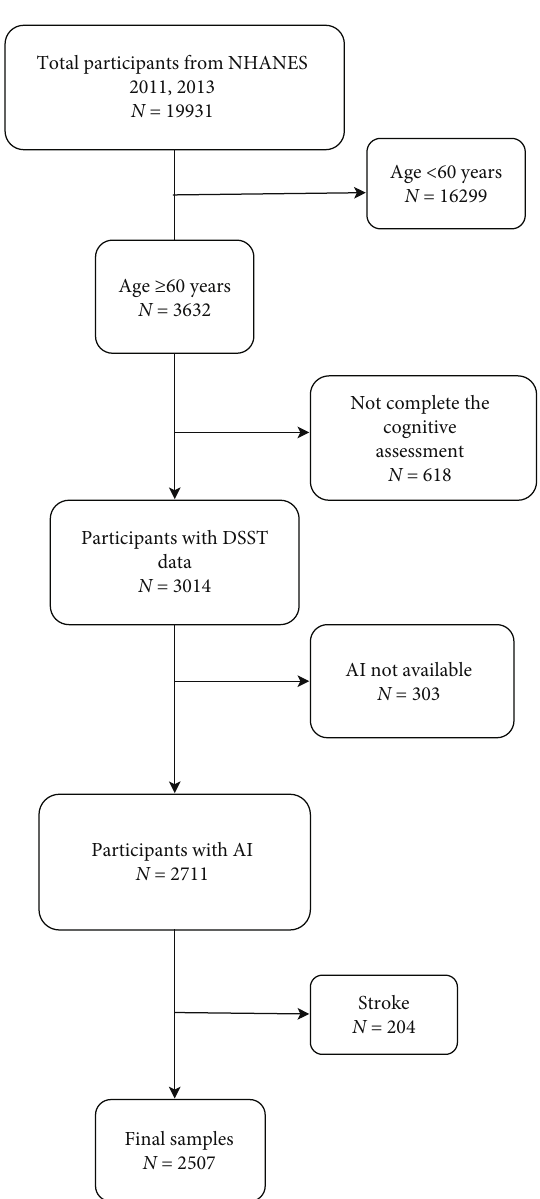
Figure 1: Flowchart of participant selection. NHANES, National Healthand Nutrition Examination Survey; DSST, digit symbol substitution test; AI, ambient